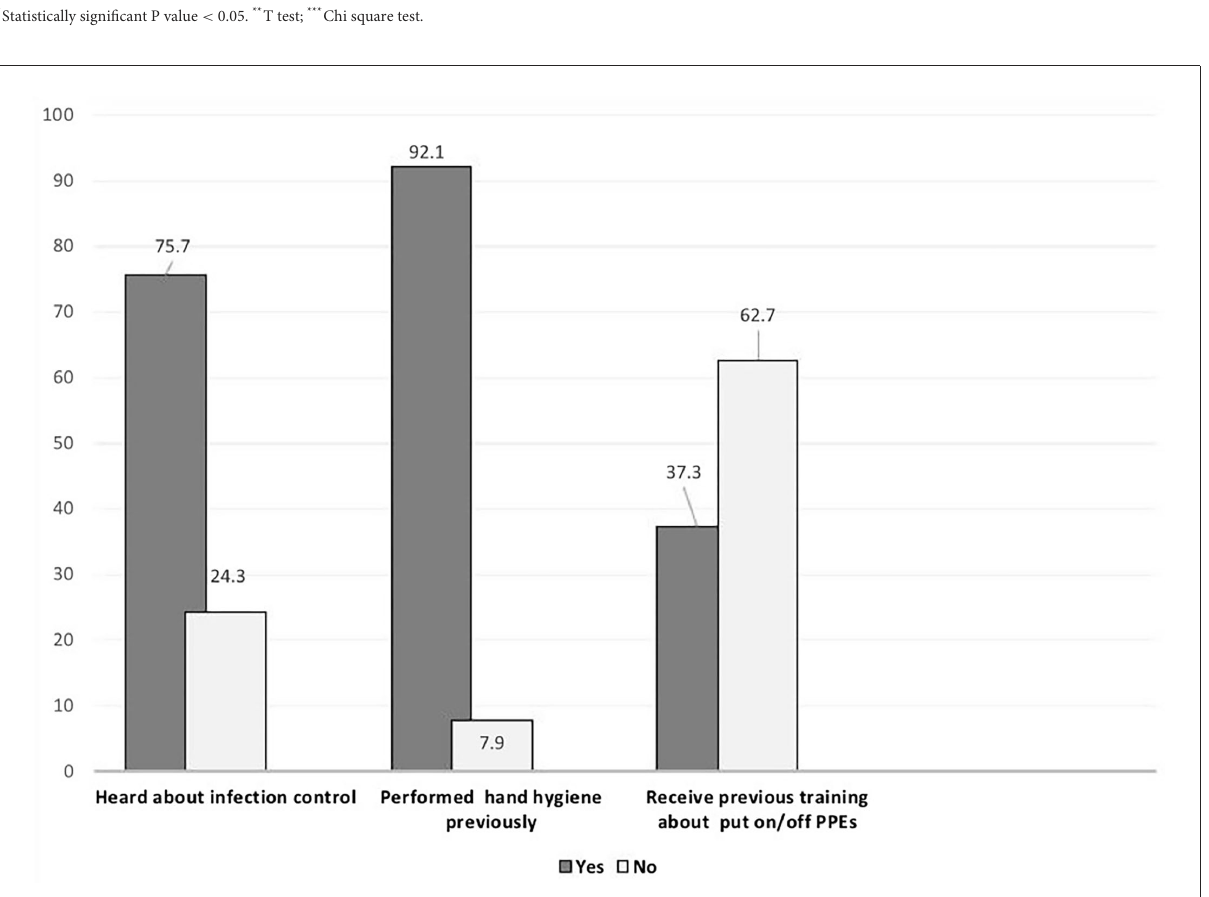
FIGURE2 Previous background of medical undergraduates about basic of infection